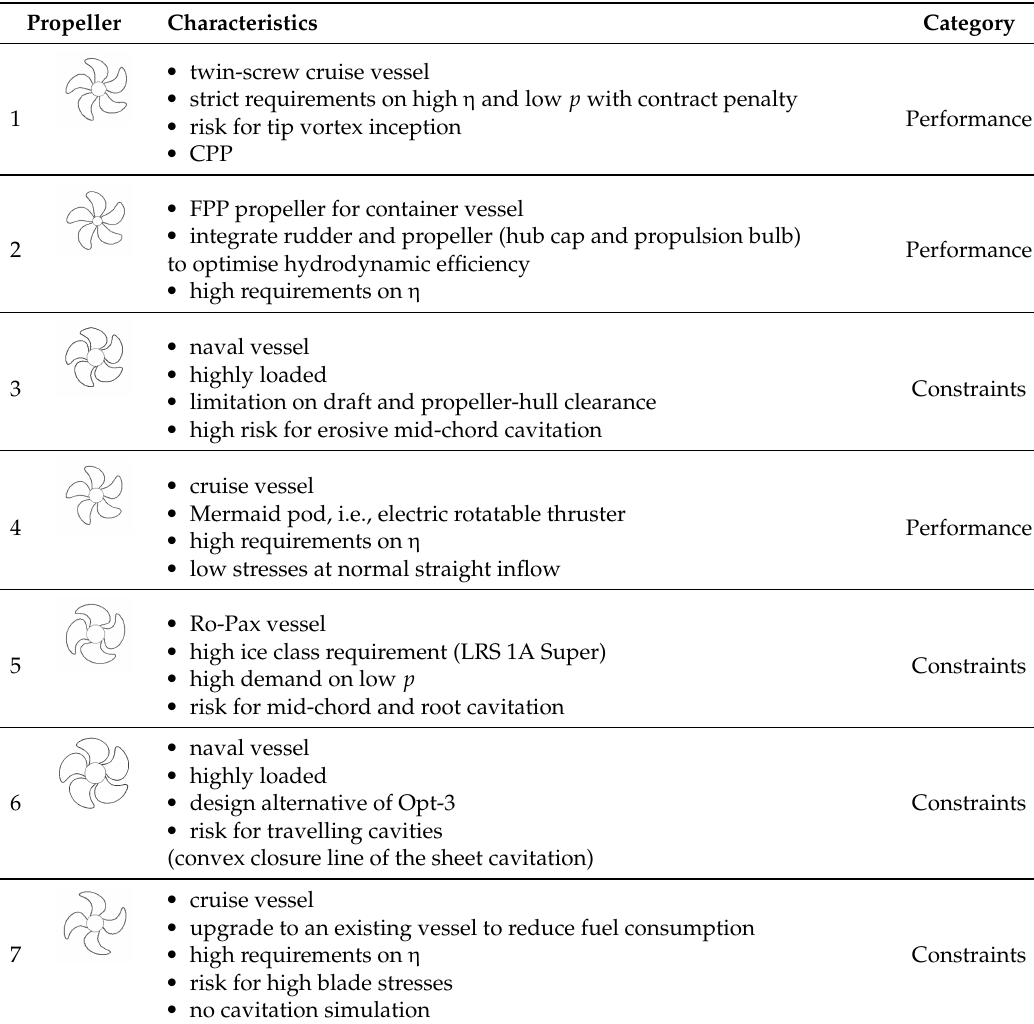
Table 3. Benchmark propeller and their